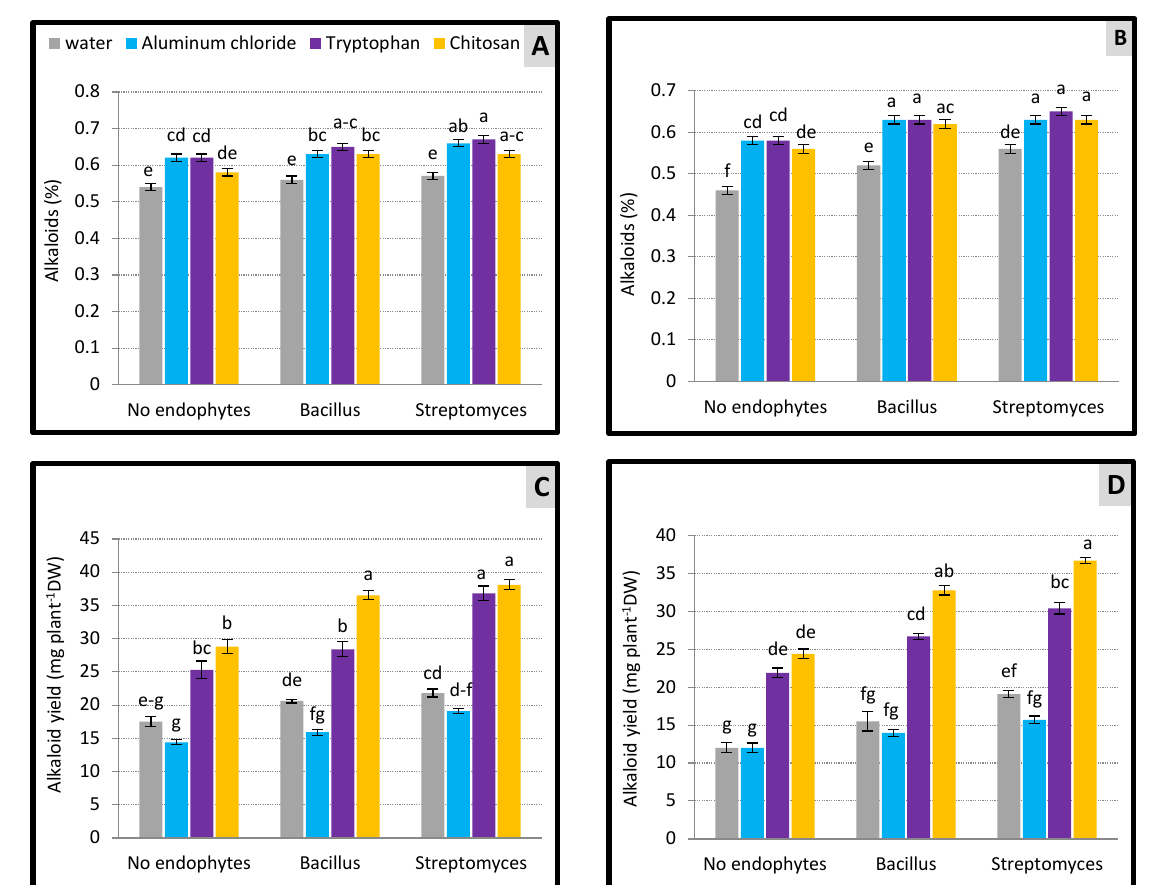
Figure 7. Interactive effect of endophytic microorganisms and abiotic elicitors on ( A , B ) alkaloid percentage and ( C , D ) alkaloid yield (mg plant −1 DW) of periwinkle plant shoot in both seasons. Columns with the same letter in each chart are non-significantly ( p ≤ 0.05) different according to Tukey’s test. Means of five replicates are presented with ±SE.